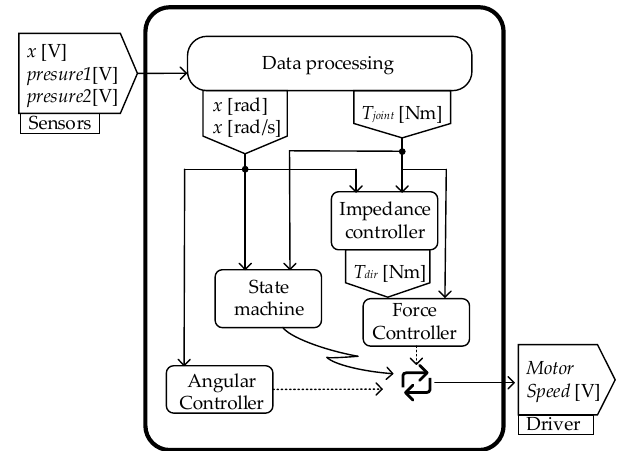
Figure 4. The controller flow chat. The control system takes the voltage signal from the sensors as